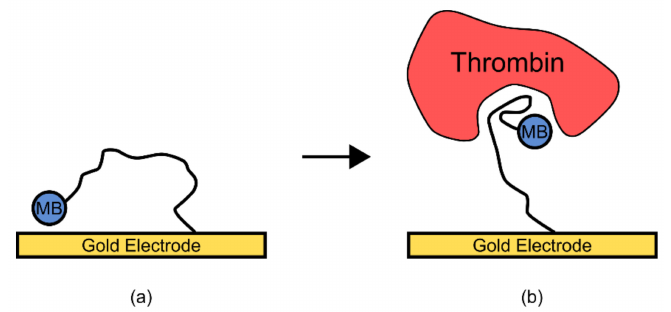
Figure 7. Thrombin biosensor. Thrombin-binding aptamer immobilized on a gold electrode with covalently added methylene blue group (MB). ( a ) In the absence of thrombin, the flexible aptamer structure allows the MB group to contact the electrode, donating an electron and generating a signal. ( b ) Addition of thrombin stabilizes secondary structure, reducing contact of the MB group with the electrode, reducing signal generation. Figure adapted from Xiao, et al.